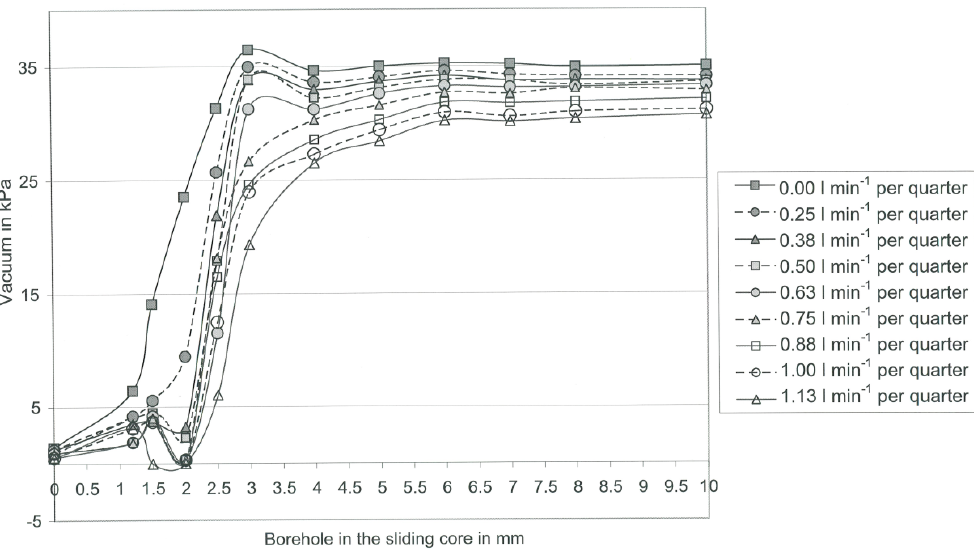
Figure 4. Characteristic curve of mean teat-end vacuum in b-phase depending on the boreholes in the sliding cores and on the liquid flow rate per udder quarter [26].